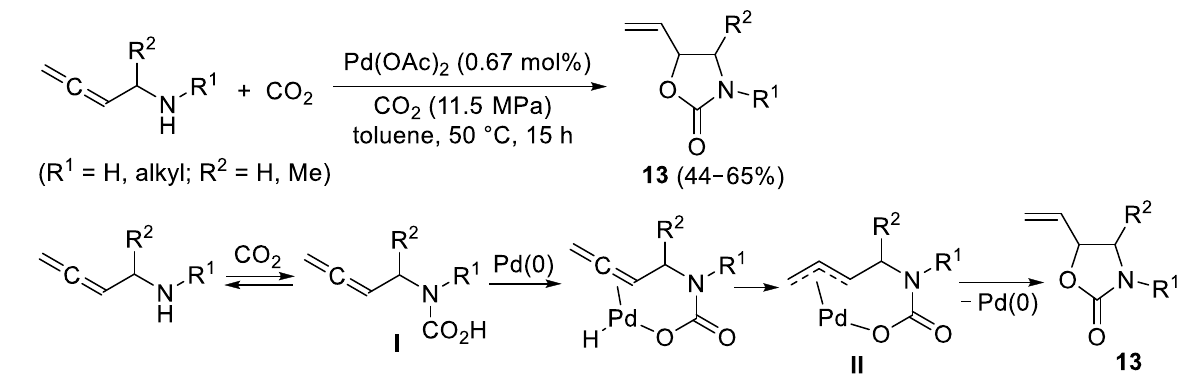
Scheme 14. Synthesis of 5-vinyl-2-oxazolidinones 13 from  -allenyl